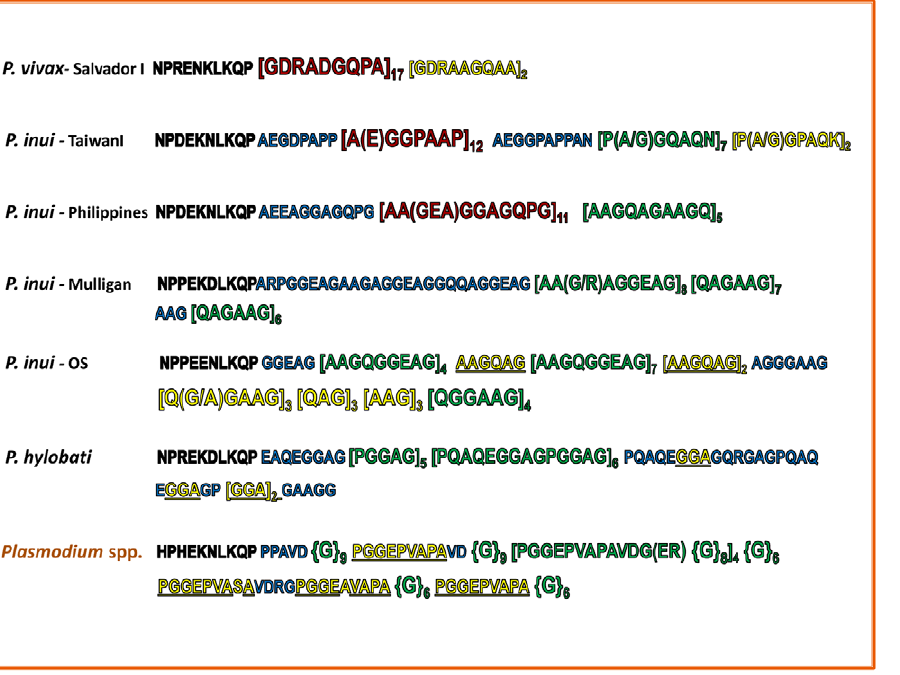
Figure 4. Amino acid composition of the Circumsporozoite protein tandem repeat sequences from P.vivax , P.inui , P.hylobati and Plasmodium spp. Repetitive motifs are reported between brackets ‘‘[]’’ followed by the number of times observed. Amino acids between parenthesis ‘‘()’’ are found in at least one of the motifs. The number of glycines observed in the orangutan lineage are indicated between braces ‘‘{}’’. Color code and size indicate relative frequency: motifs found in tandem of 10 and more are indicated in red, motifs found in tandem of 4 to 9 are indicated in green, and motifs found in tandem from 2 to 4 are indicated in yellow. Blue sequences still show low complexity but not a discernible motif.